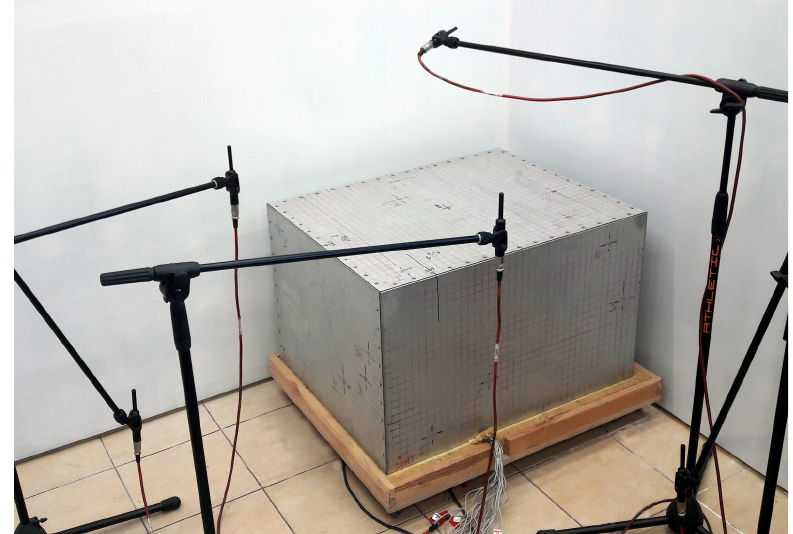
Figure 1. The laboratory